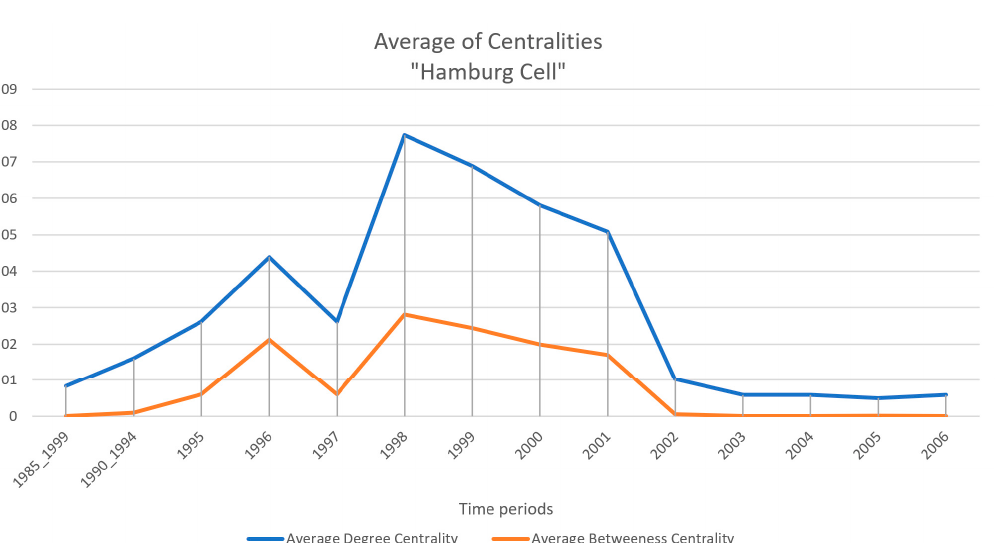
Figure 13. Temporal development of average degree centrality and average betweenness centrality for the “Jamaah Islamiah section of Indonesia”. Both indices increase, reach a maximum and then decrease. The average degree centrality reaches its maximum in 2004, while the average betweenness centrality does so in 2003.